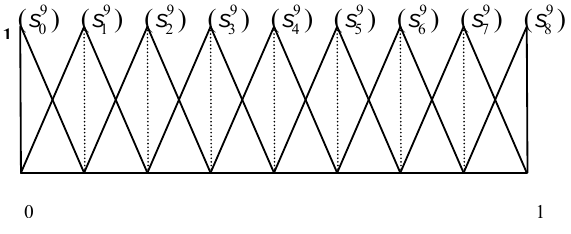
Fig. 4. Membership functions of linguistic variables at level 3 ( t